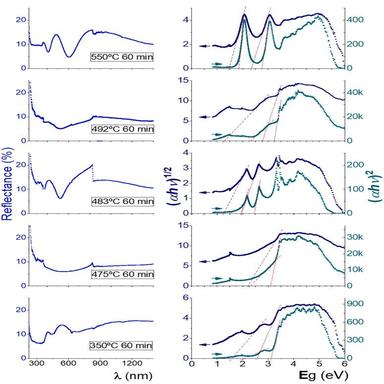
BZT thin films reflectance, (αhν) 1/2 and (αhν) 2 plots vs. incident photon energy. Optical Eg calculated via linear extrapolation of Tauc's method.